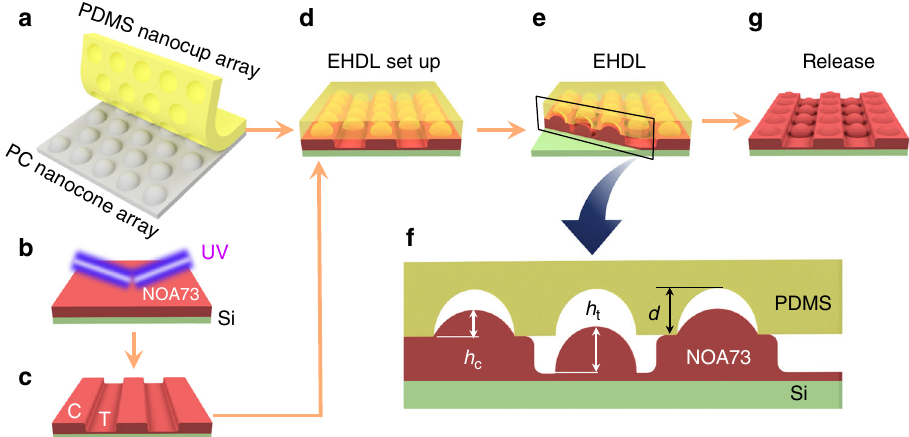
Fig. 3 Fabrication steps for tribocharge-enabled EHDL of photopolymer. a Liquid-phase PDMS is poured onto the PC mold textured with a 2D triangular nanocone array. After thermal curing, the PDMS replica, textured with a nanocup array, is peeled off. Its surface becomes selectively tribocharged during this demolding process. b A UV-curable photopolymer (NOA73) is spin-coated on a silicon substrate and exposed to a UV-two-beam interference pattern. c The NOA73 thin fi lm is textured sinusoidally with well-de fi ned crest (C) and trough (T) areas due to local volume shrinkage. d The tribocharged PDMS nanocup array is placed on the sinusoidally textured NOA73 fi lm. e NOA73 in the trough region is attracted upward by the spatially modulated electric fi elds originated from the tribocharges and undergoes EHDL. NOA73 on the crest experiences forces from both the capillary action and Coulomb attraction. f The cross-sectional pro fi le de fi nes the heights of the nanostructures in the crest ( h c ) and trough ( h t ) areas along with d , the nanocup depth. g The fi nal UV-induced solidi fi cation of NOA73 and removal of the PDMS nanocup array completes the tribocharge-enabled EHDL of